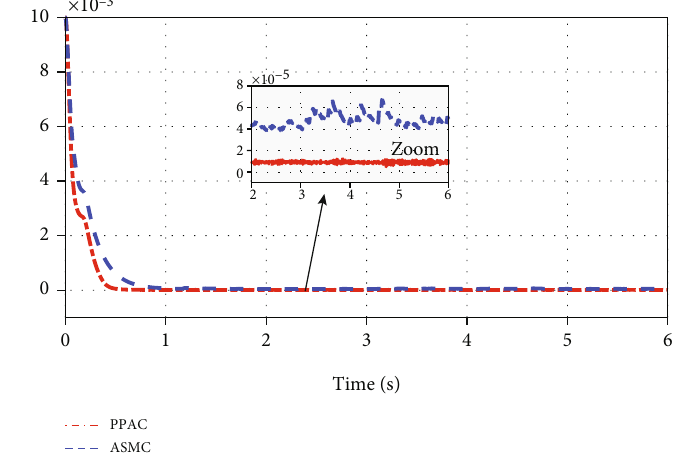
Figure 13: h responses of the closed-loop system with Case 2.